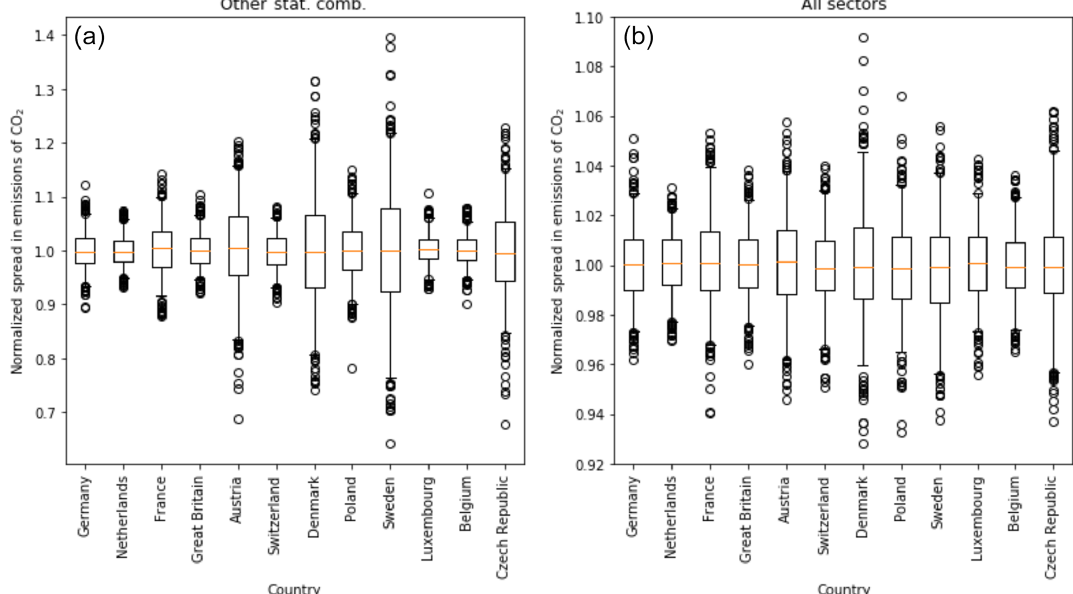
Figure 9. Normalized spread in emissions of CO 2 for other stationary combustion (a) and all sectors combined (b) for a range of countries. The box represents the interquartile range, the whiskers the 2.5–97.5 percentiles, the lines the median values, and the circles are outliers.